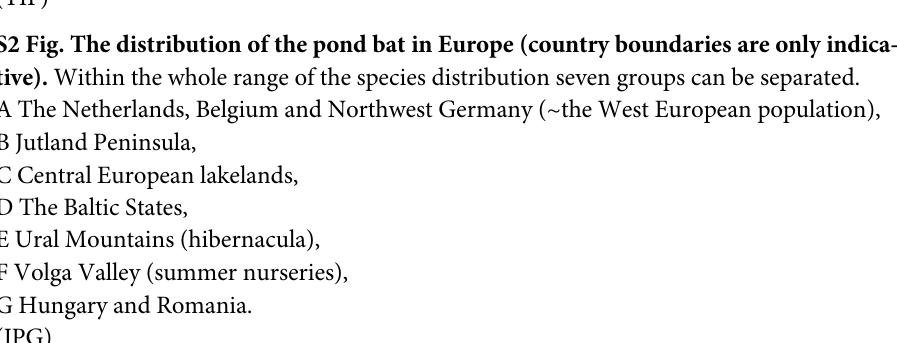
S3 Fig. The distribution of hibernacula used by the western pond bat population. These are sites with three or more records of pond bats in one or both study periods. We identified four roost categories: Roosts which have been used ever since 1900 (= green squares), roosts used only between 1900–1980 (= open black squares), roosts occupied after 1980 (= purple circles), roosts occupied after 1997 (= blue asterisks). Detailed maps, all with the same enlargement, of the clusters in the provinces of Zuid-Holland (1), Gelderland (1) and Limburg (3) are pro- vided. S1 Table. Summary of the average weight of pond bats over the study period. The weight is averaged per week. The table gives average weight of females, males both adults and juveniles. (XLS) S2 Table. Mark and recapture data from the historical dataset. (XLS) S3 Table. Mark and recapture data from the recent dataset.